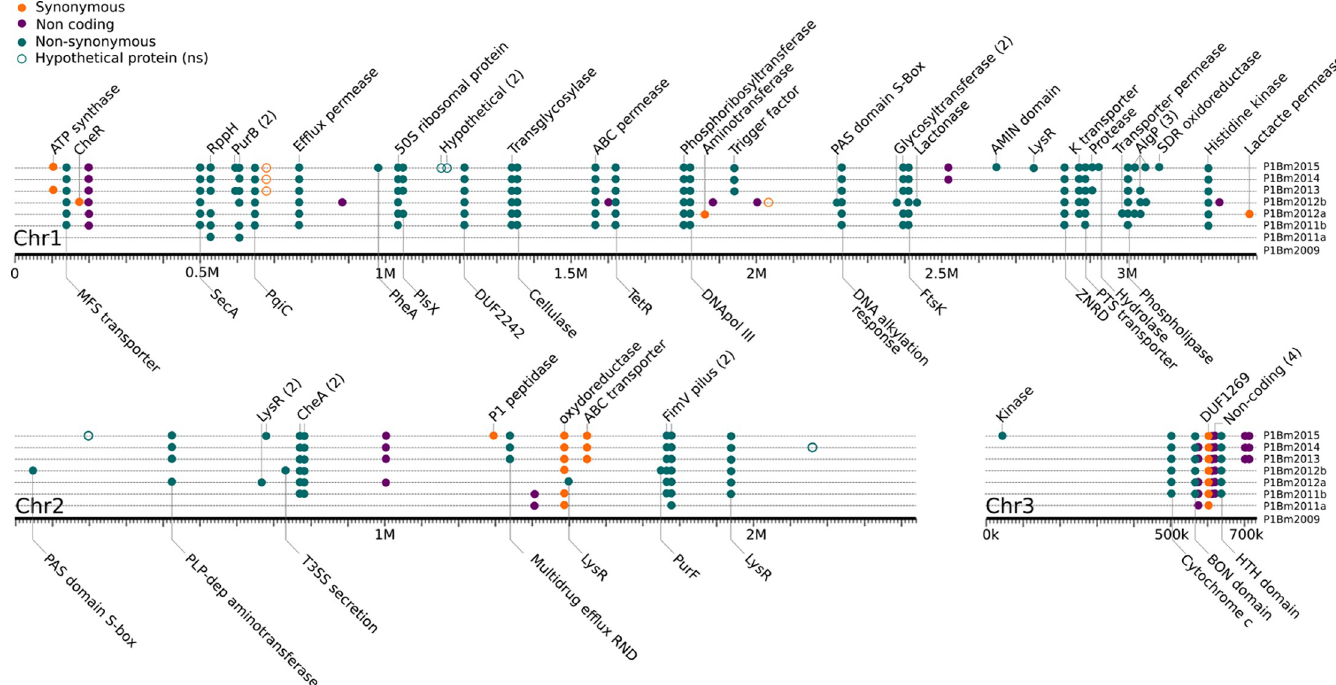
Fig 8. Longitudinal evolution of isolates from patient 1. Single nucleotide polymorphisms (SNPs) are shown for each of the three chromosomes of B . multivorans . When available, we additionally indicate the annotated function that is associated with the locus. The mutations that occur at multiple independent positions in the same locus, which are indicative of selective pressure, are marked with number between parentheses (Table